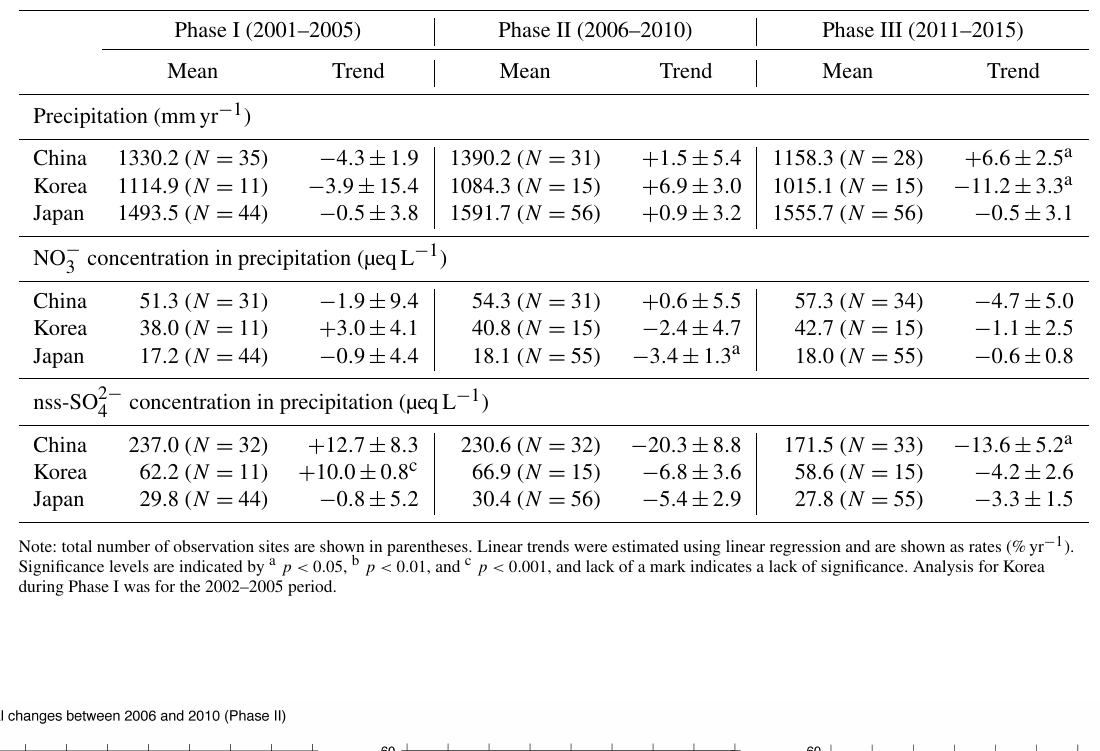
Table 2. Statistical analysis of average values and linear trends for precipitation, NO − tration in precipitation over China, Korea, and Japan during phases I, II, and III.